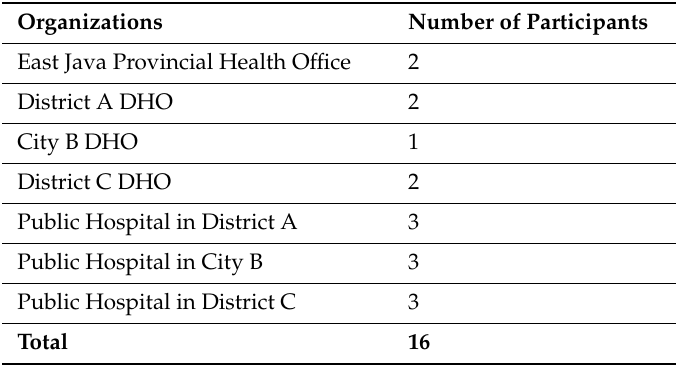
Table 2. Number of interview participants and their